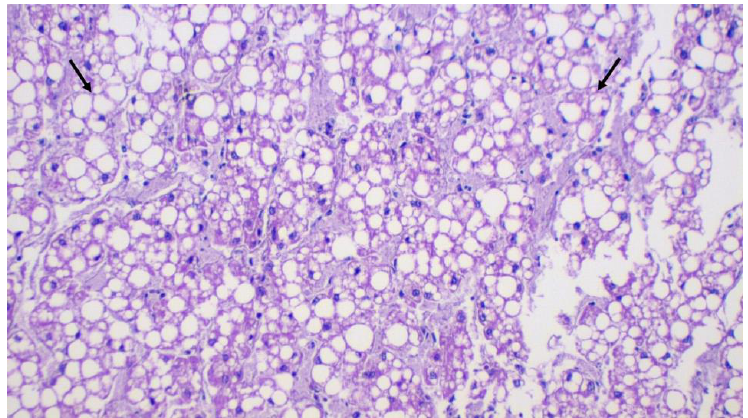
Figure 3. Histopathological analysis of the liver of a tiger shark with bile accumulation (SBA2). Black arrows indicate hepatocytes filled by large intracytoplasmic vacuoles. H&E, 20× increase.